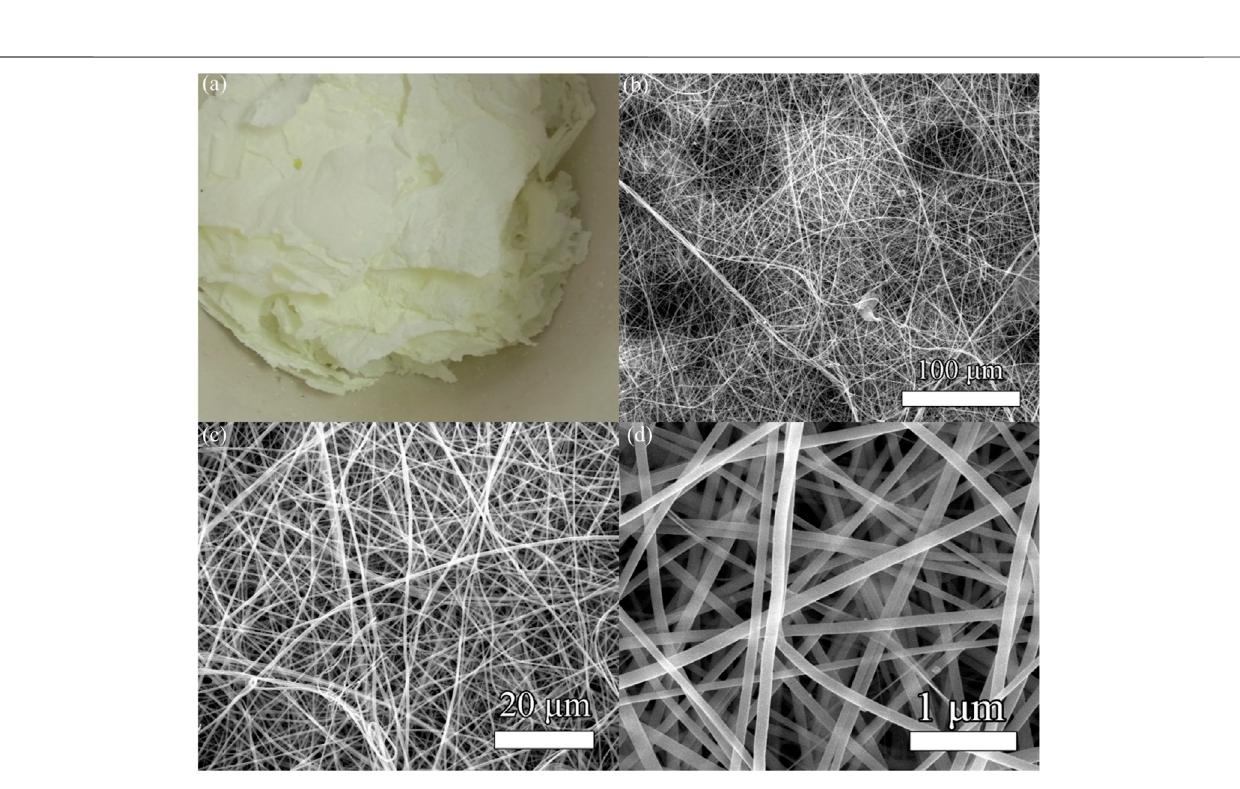
Frontiers in Materials |